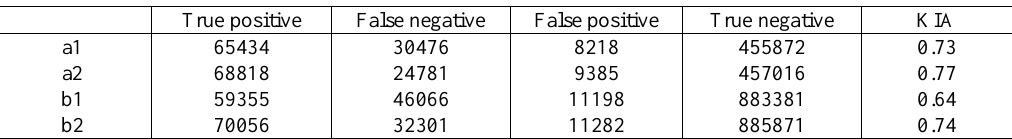
Table 2. Pixel based building footprint